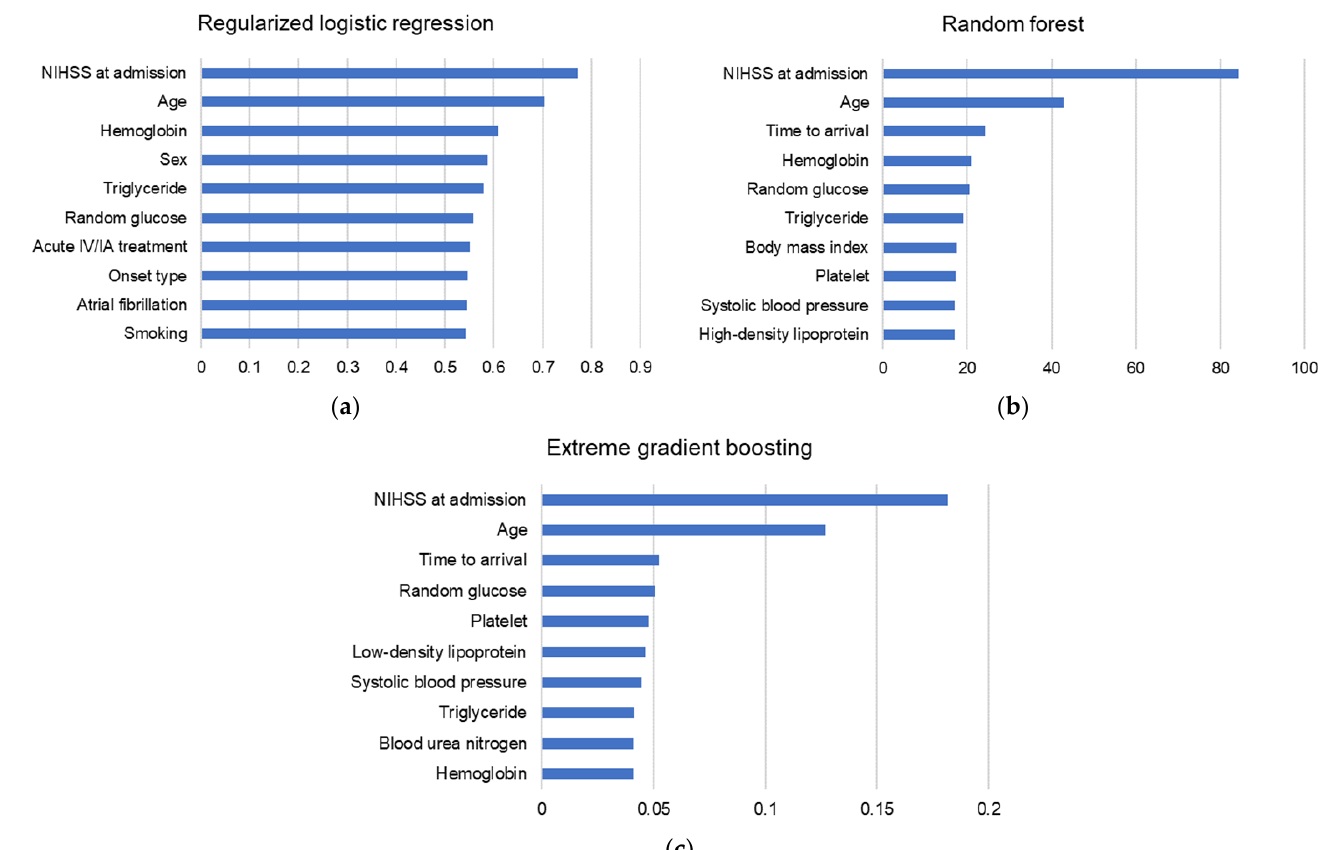
Figure 4. Top ten important variables in ( a ) regularized logistic regression, ( b ) random forest, and ( c ) extreme gradient boosting models. The top two important features were consistent in all three models; NIHSS at admission, followed by age. Additionally, random glucose, hemoglobin, and triglyceride were also included in the top ten important variables in all three models. NIHSS, National Institute of Health Stroke Scale; IV, intravenous; IA, intraarterial.